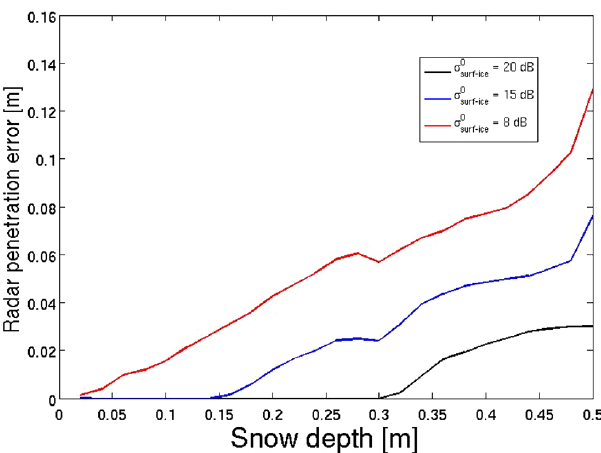
Figure 15. Plot of the error which is present in the retrieval of freeboard for the CS2WfF method under the assumption that only backscattered power from the sea ice surface is present. The er- ror is a function of snow depth; three cases are shown for varying strengths of the sea ice surface